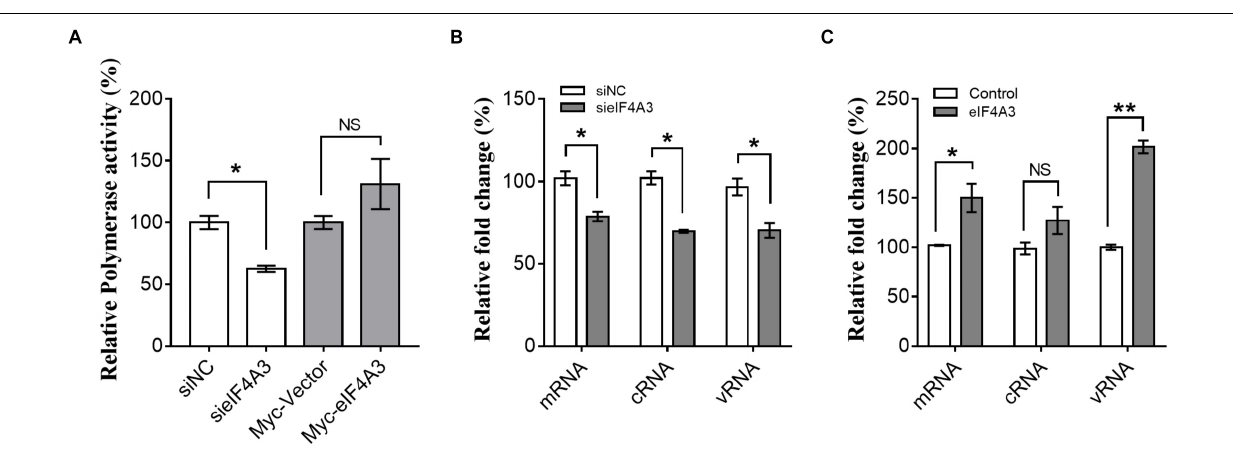
FIGURE 5 | Role of eIF4A3 during the replication cycle of influenza virus. (A) HEK-293T cells treated with eIF4A3 siRNA or overexpress plasmids. At 36 h post-transfection, cells were transfected with firefly minigenome reporter and Renilla expression control. (B) Cultures of HEK-293T cells were transfected with eIF4A3 or NC siRNA. Thirty six hours after post-transfection, cells were infected with influenza A/Guangdong/V at an MOI of 1. Relative vRNA, cRNA, and mRNA expression of segment 1 was measured by strand-specific real-time RT-qPCR after 24 hpi. The expression of vRNA, cRNA, and mRNA in siNC cells was set to 1. (C) eIF4A3 or empty vector were expressed for 24 h before being infected with influenza A/Guangdong/V at an MOI of 1 and then incubated at 37 ◦ C for 24 h before reverse transcription followed by qRT-PCR for vRNA, cRNA, and mRNA of segment 1. The data are shown as means ± SD ( n = 3) and the statistical significance of differences from the data obtained for control cells was determined using the Student t- test ( ∗ p < 0.05; ∗∗ p <